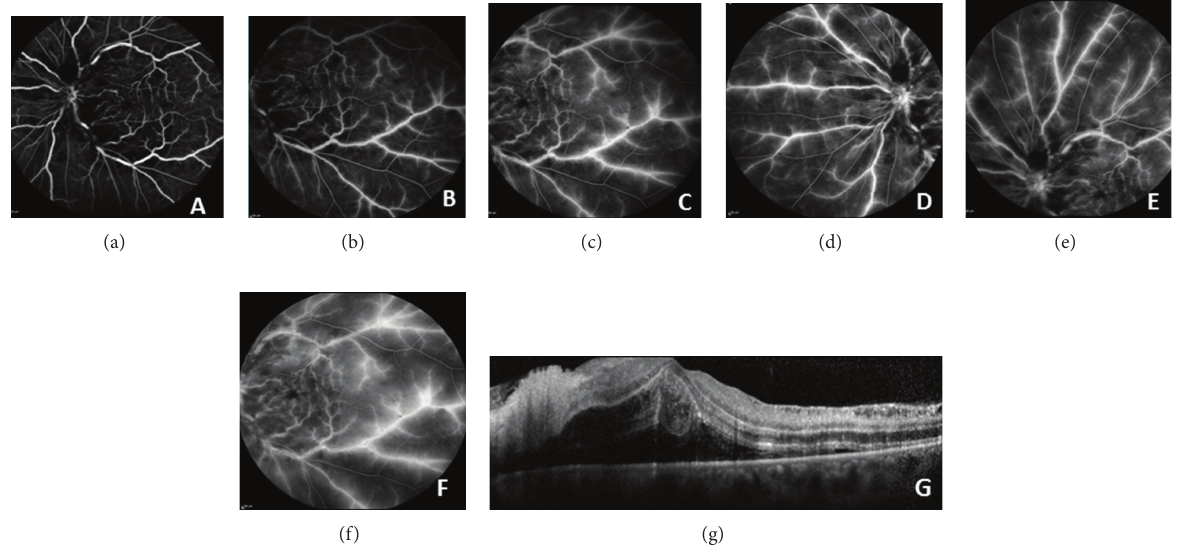
Figure 2: (a) Early phase of fluorescein angiography showing multiple areas of hypofluorescence due to intraretinal hemorrhages and intermediate and late phase of fluorescein angiography ((b), (c), (d), (e), and (f)) showing leakage from the optic disk and extensive vasculitis. (g) Optical coherence tomography (OCT) shows detachment of the neurosensory